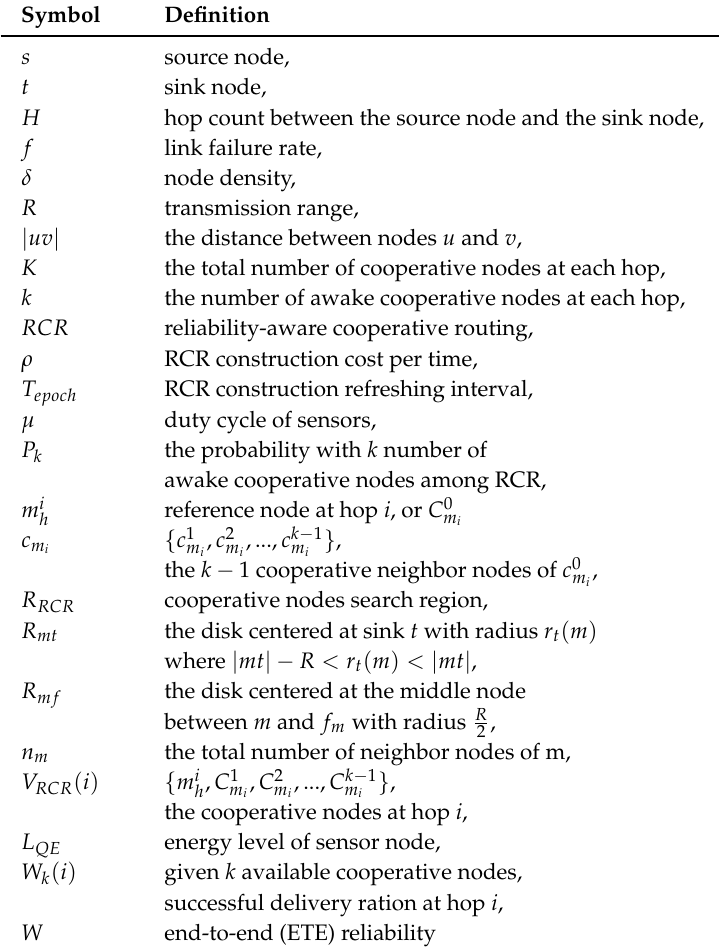
Table 1. Notation. RCR, reliability-aware cooperative